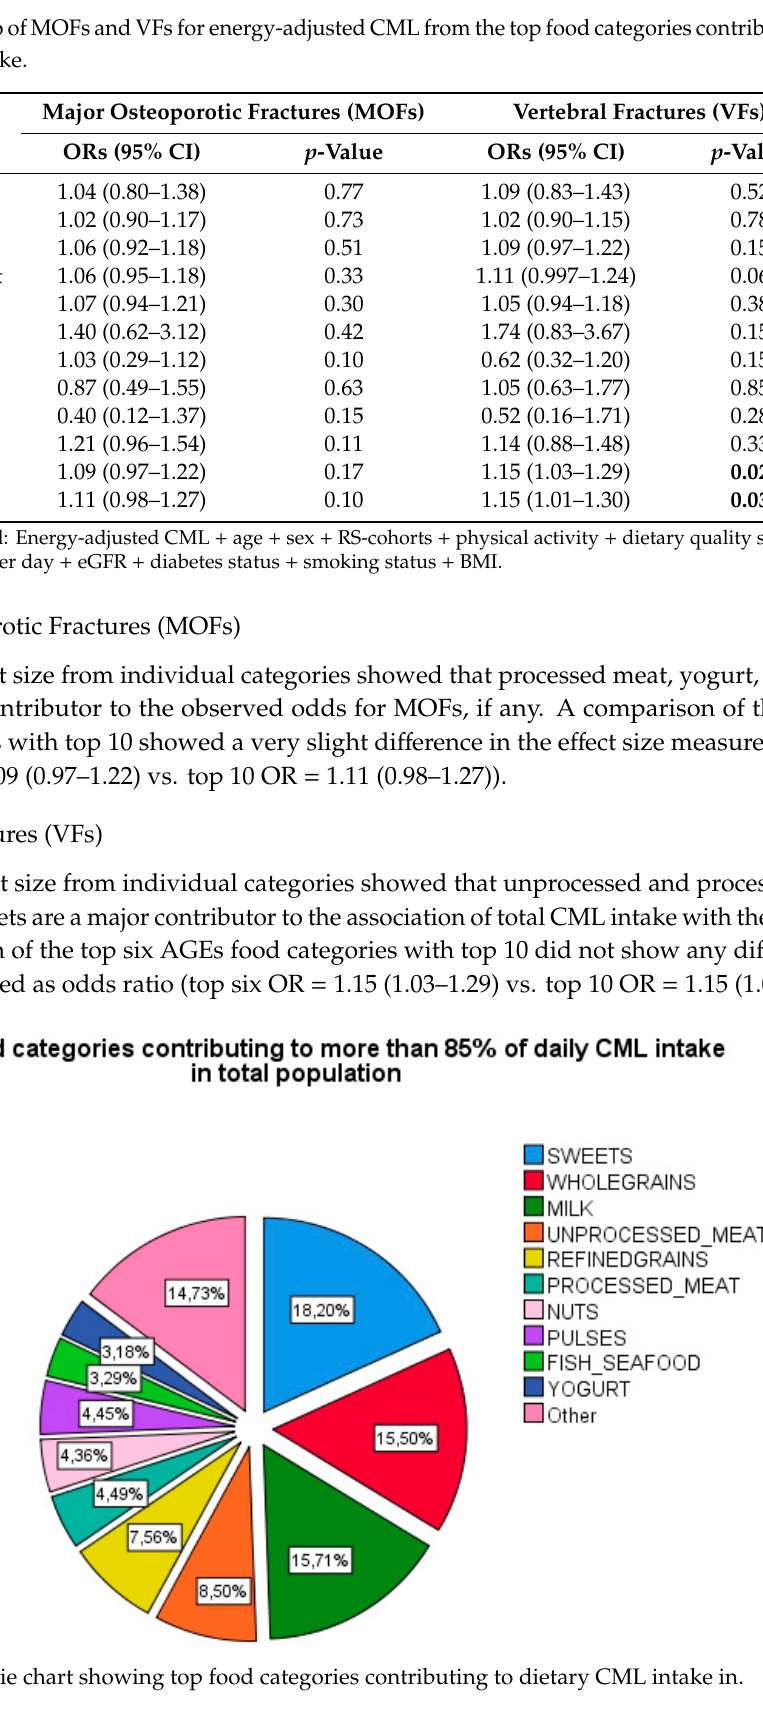
Figure 3. Pie chart showing top food categories contributing to dietary CML intake in.